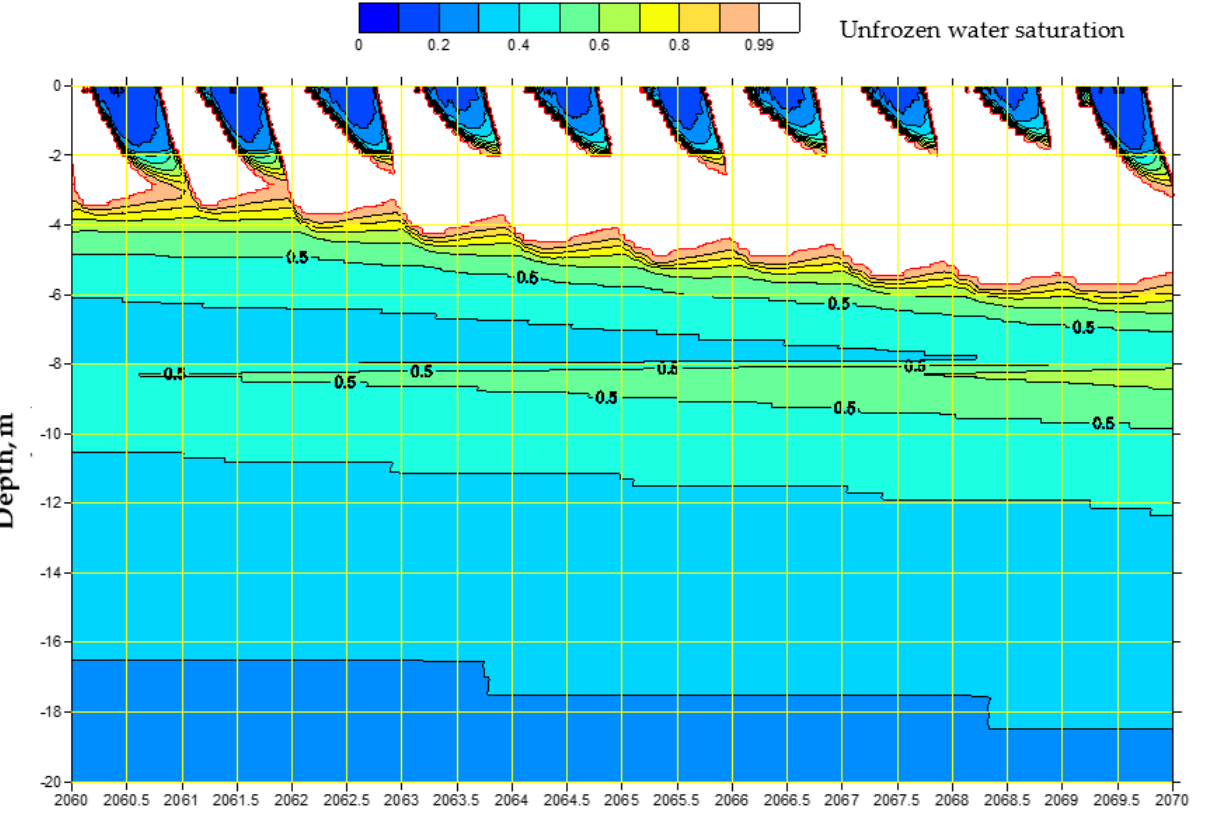
Figure 4. Forecast of the unfrozen water saturation dynamics vs. time (years) for Point “631—Marre- Sale” (Western Yamal), scenario RCP-8.5, undisturbed